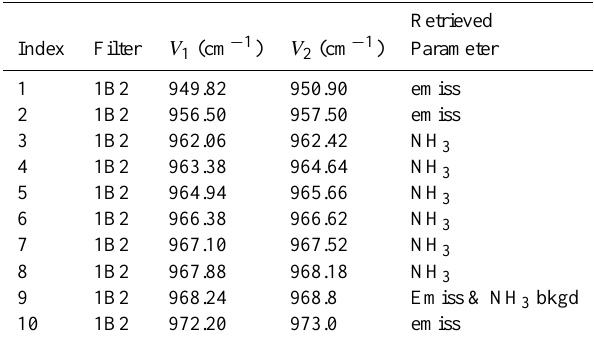
Table 1. Microwindows for TES NH 3